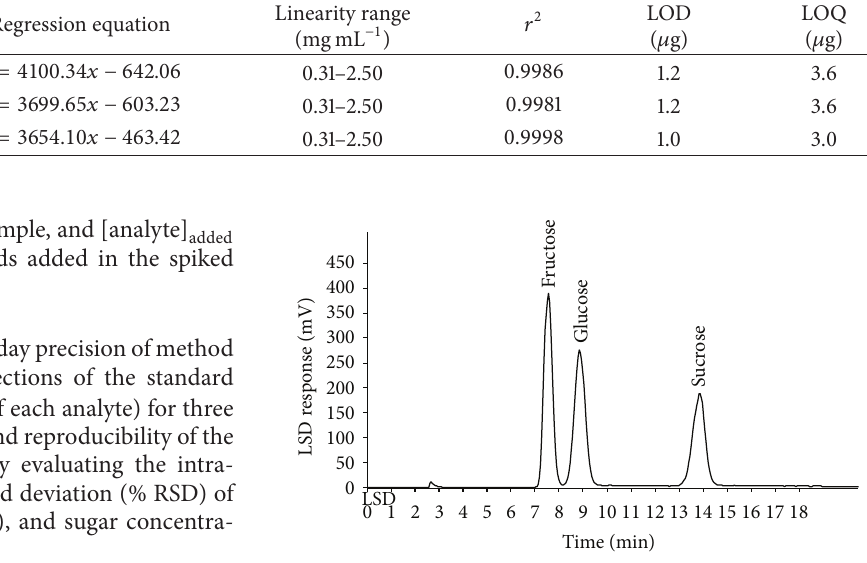
Figure 1: HPLC-ELSD profile of fructose, glucose, and sucrose standard compounds.